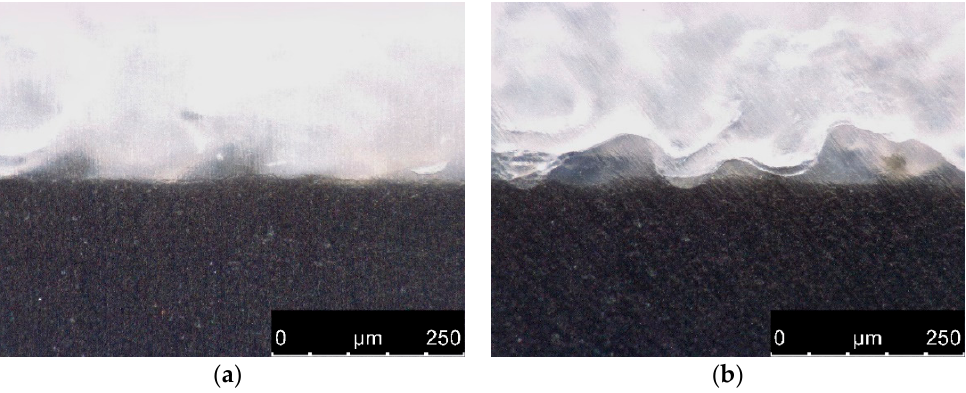
Figure 6. Binding area of PA12 (white) on PA6 (black) in dependence of preceding laser exposure. ( a ) Without creation of a local melt pool a clear boundary line is visible. ( b ) After 6 exposure cycles the dark grey fusion domain is enlarged and the interfacial area becomes blurred, increasing the inter-polymer bonding.